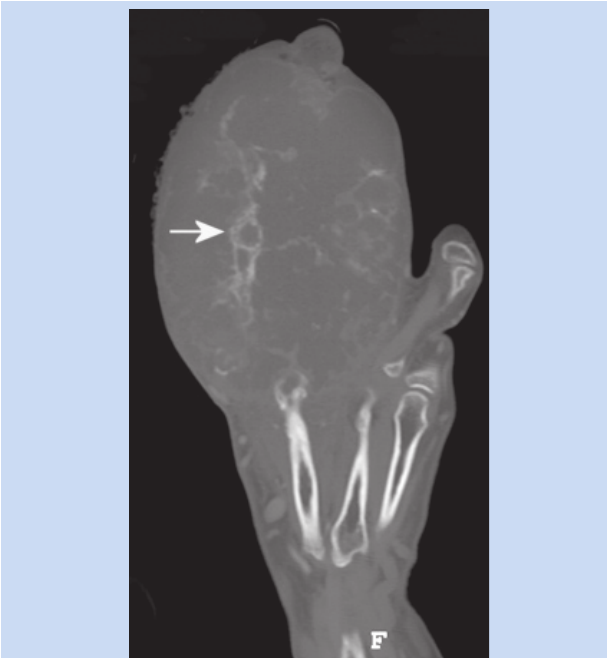
Fig. 2a. Coronal reconstructed image in bone window setting showing the left hand index finger mass with central speckled calcifications with ring- and-arc pattern in the central region of the mass (white arrow).